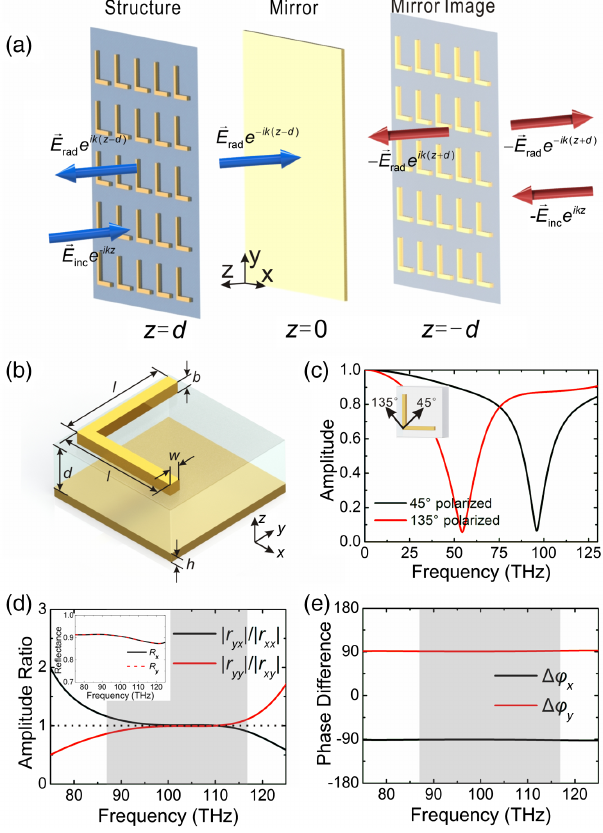
FIG. 1. (a) Schematics to show the interaction of light with each interface of the system made of an array of L patterns ( z ¼ d ) in front of a perfect electric conductor ( z ¼ 0 ). The mirror image of the array is located at z ¼ − d . (b) Structural parameters of the L pattern. The thickness of the silver mirror layer is h ¼ 100 nm, SiO d ¼ 510 nm. The length l , 2 layer thickness is width w , and thickness b of each arm of the L pattern are 1220, 120, and 120 nm, respectively. The lattice constant is 1550 nm. (c) Simulated transmission of a layer of gold L-pattern array only, without the silver mirror layer underneath. The black and red lines are the normalized amplitude of the electric component of the transmitted light of 45°-and 135°-polarized incidence. (d) Simulated amplitude ratio of the reflected light, which becomes unity in the shaded frequency band. The inset shows the total reflectance. (e) Simulated phase difference of the reflected light, which is either 90° or − 90